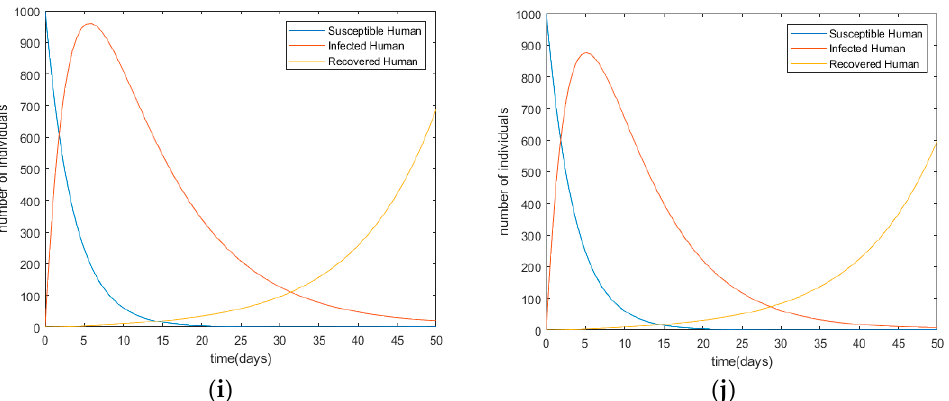
Figure 4. Changes in infection trends toward the human population with each control scenario ( a )